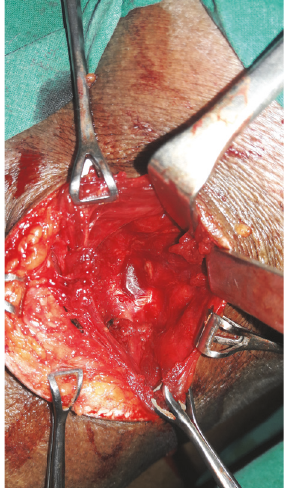
Figure 1: Hernia arising from the lumbar region just below the twelfth rib on the right side.